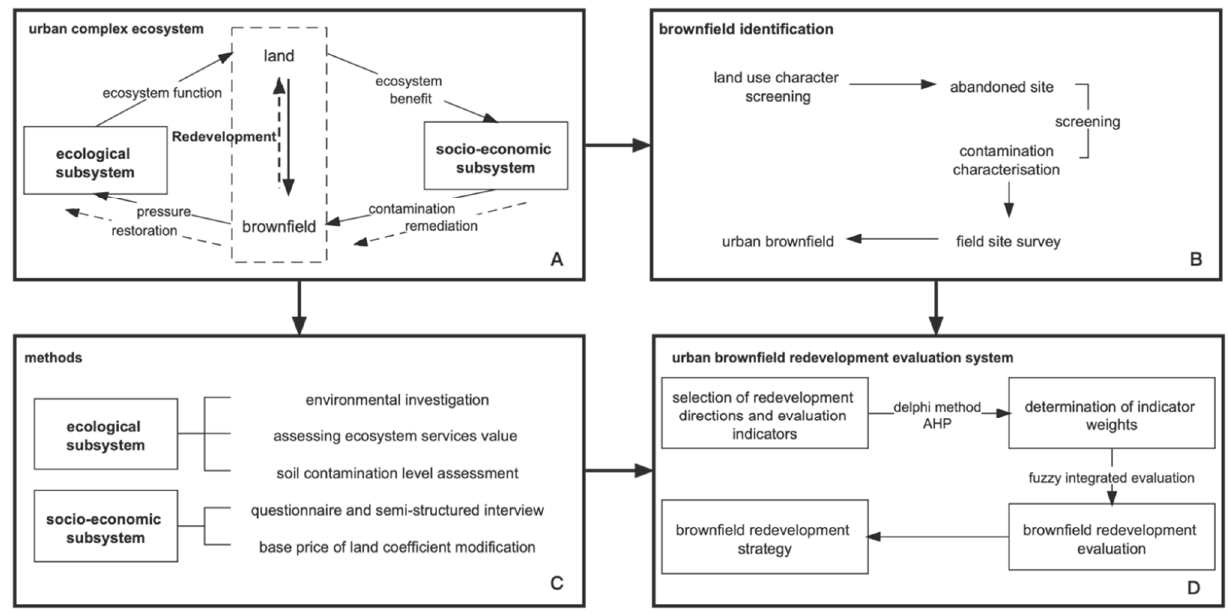
Figure 1. Conceptual framework and workflow for brownfield identification and redevelopment assessment in complex urban ecosystems. ( A ) conceptual framework for urban complex ecosystem, ( B ) brownfield identification process, ( C ) methods, ( D ) evaluation system of urban brownfield redevelopment. Source: own study redrawn from [17,23].